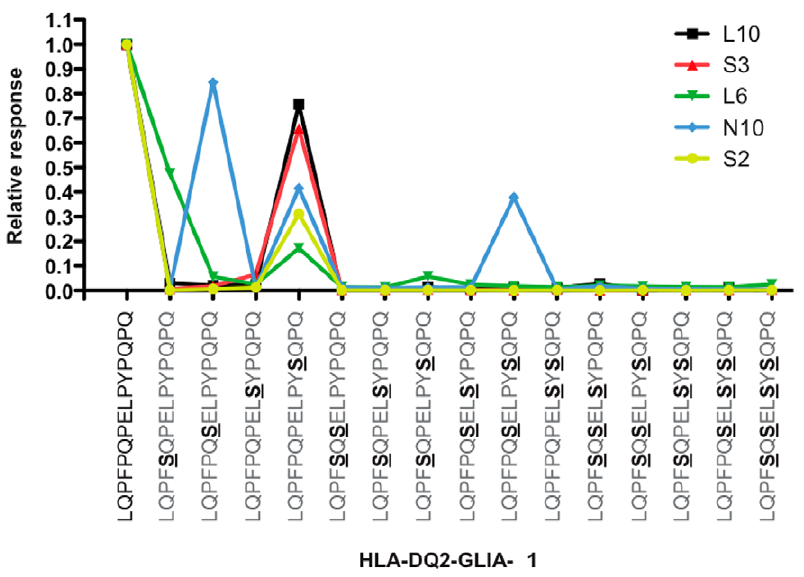
Figure 3. Response of DQ2-Glia- a 1 epitope specific T cell clones against single and multiple P to S substituted peptides. Five T cell clones derived from 3 CD patients were tested against the deamidated form of the DQ2-Glia- a 1 peptide (sequence PFPQPELPY) and variants thereof in which prolines at position 3, 5, 8 and 10 were systematically substituted for serine, both as single substitutions and in all possible combinations. Shown is the response to the substituted peptides relative to unsubstituted DQ2-Glia- a 1 epitope. The introduced substitutions are underlined. The most C-terminal substituted proline at position 10 lies outside the 9 amino acid core of the T cell stimulatory peptide.